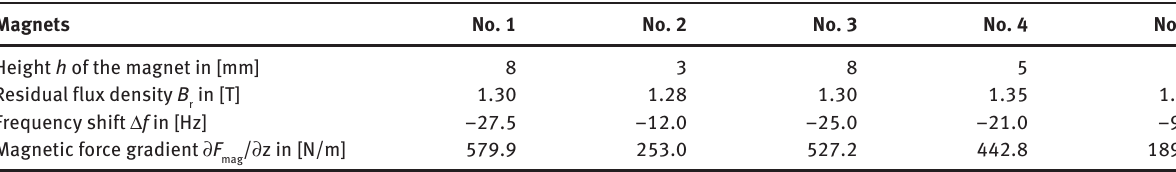
Table 1: Quantitative experimental results for second sample sledge.